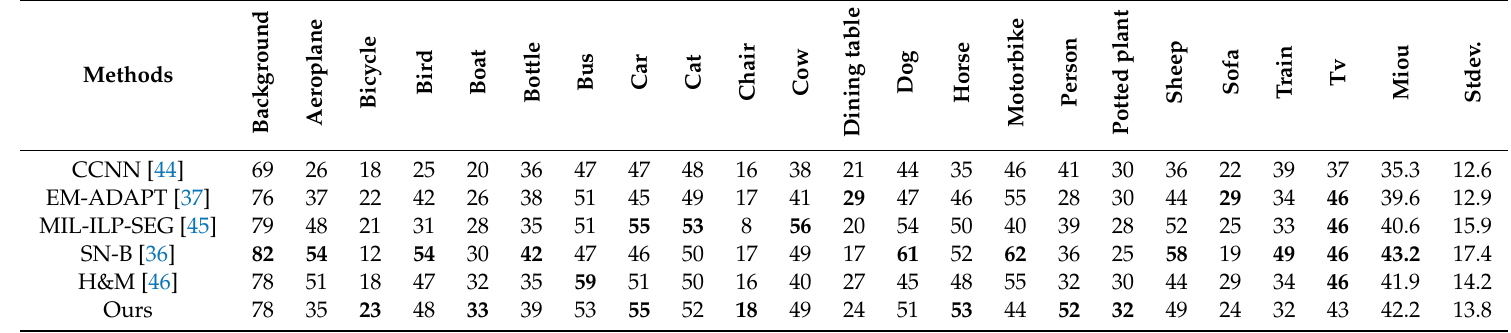
Table 3. Comparison with the state-of-the-art algorithms in term of IOU (%) on the PASCAL VOC 2012 dataset.